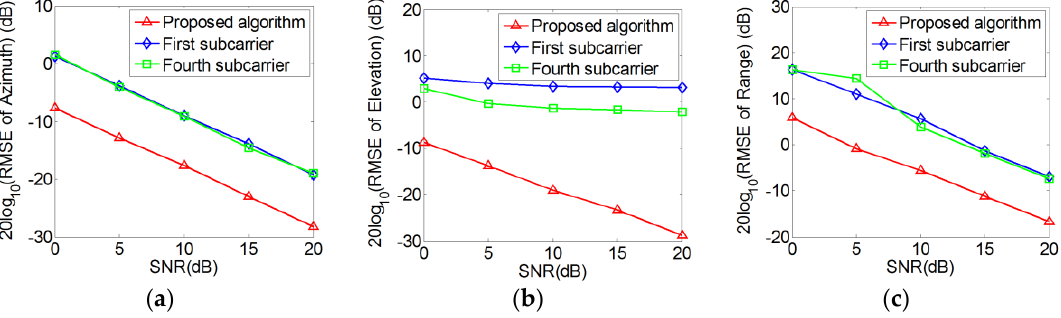
Figure 7. RMSEs versus SNR: ( a ) Azimuth angle; ( b ) Elevation angle; ( c ) Range.